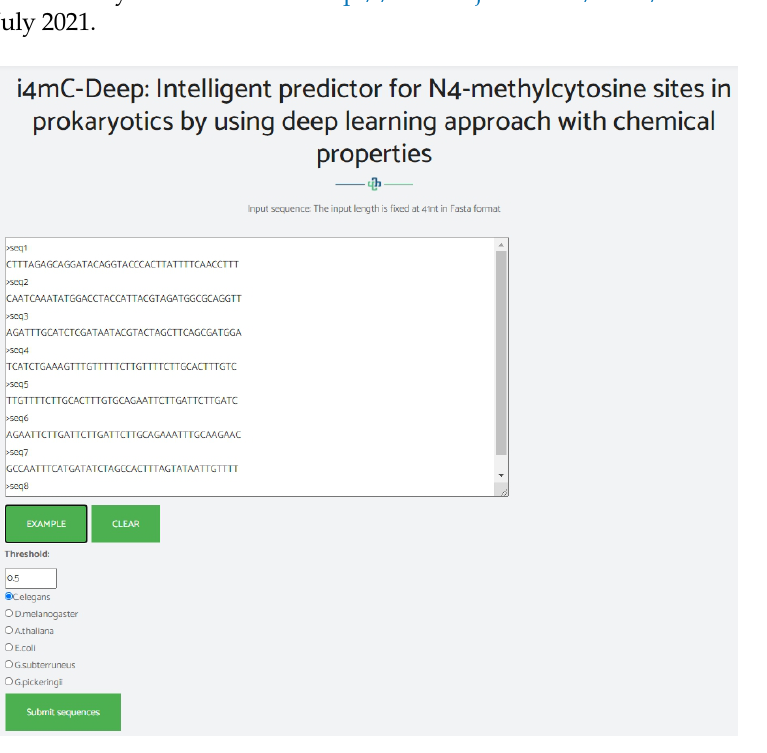
Figure 7. Demonstration of the web-server window where the users can put the DNA sequences in Fasta format directly for the prediction of 4mC site.